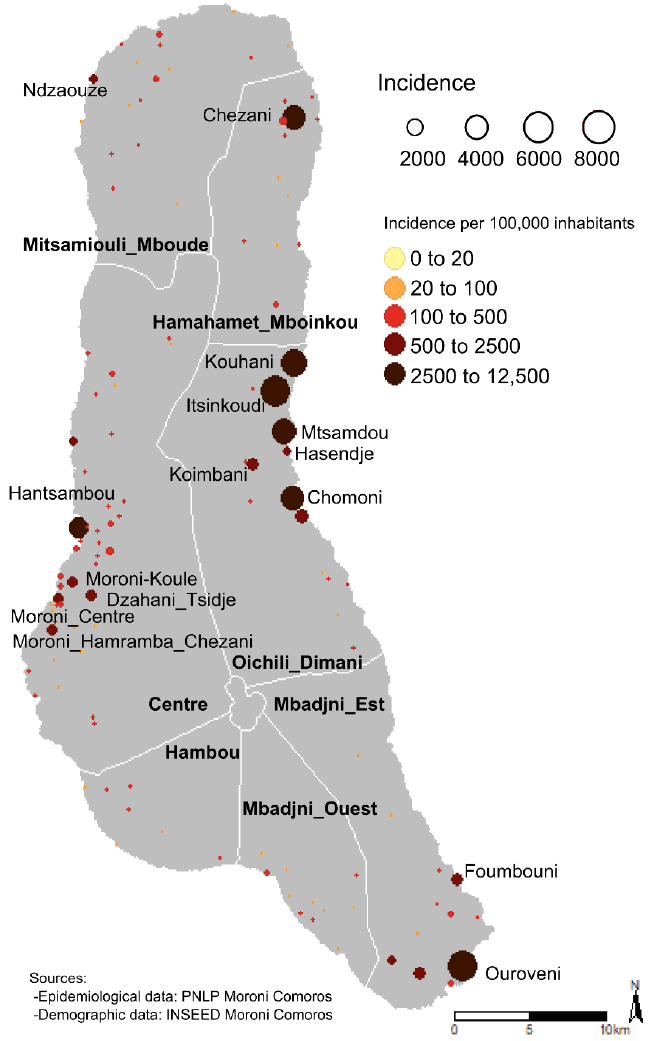
Figure 2. Malaria Incidence by locality in Grande Comore in 2016.